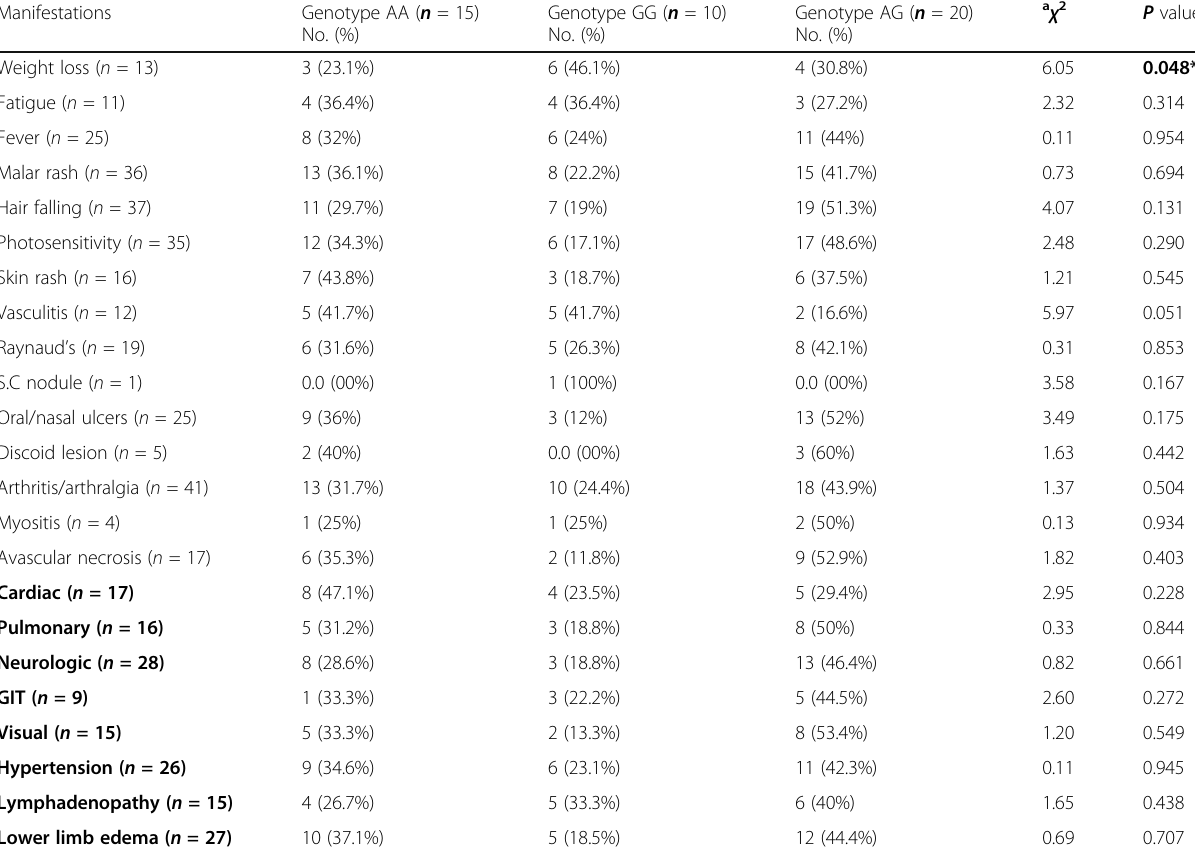
Table 2 XRCC1 Arg 399 Gln polymorphism with clinical manifestations among SLE patients ( n = 45)